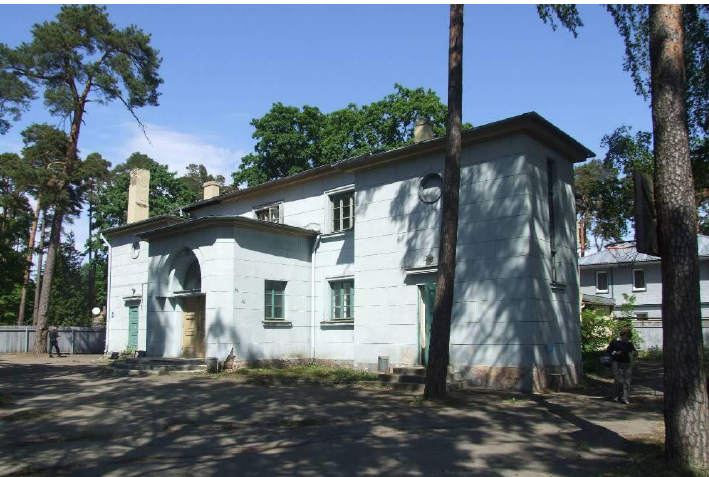
Figure 12. Majori Synagogue, Jūrmala, 1929– 1939. View from the southwest. Photo by the author, 2009.